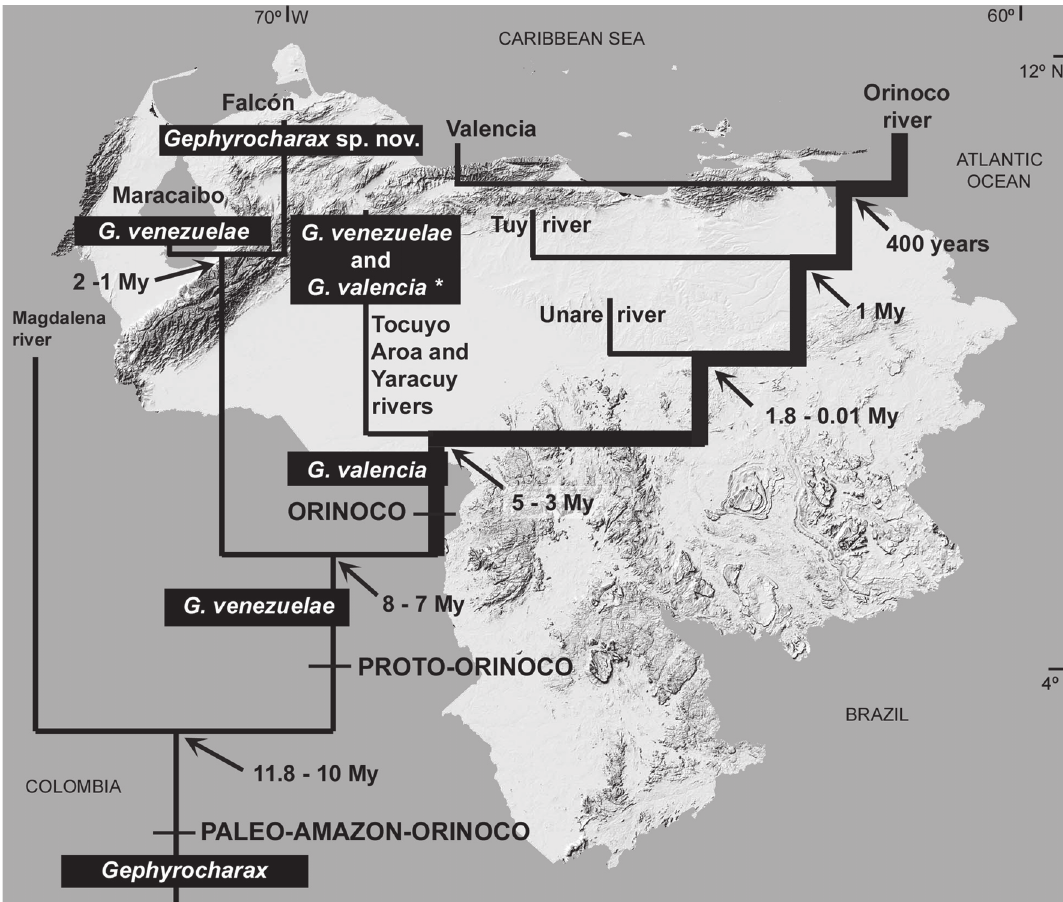
Fig. 3. Scheme for the possible origin of the species of Gephyrocharax in Venezuela. Hypothesized changes in the course of the Orinoco River in Venezuela and how they may have influenced the formation of major watersheds within the country follow Rod (1981), Díaz de Gamero (1996), and Lundberg et al. (1998). Major river basins in Venezuela are depicted in Fig. 1. (*) indicates